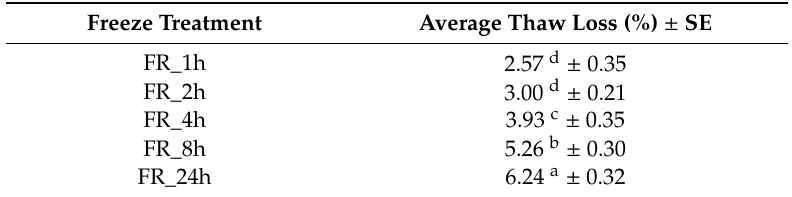
Table 2. Average percentage thaw loss for all the freezing treatments ( ± SE) calculated for the intact whole